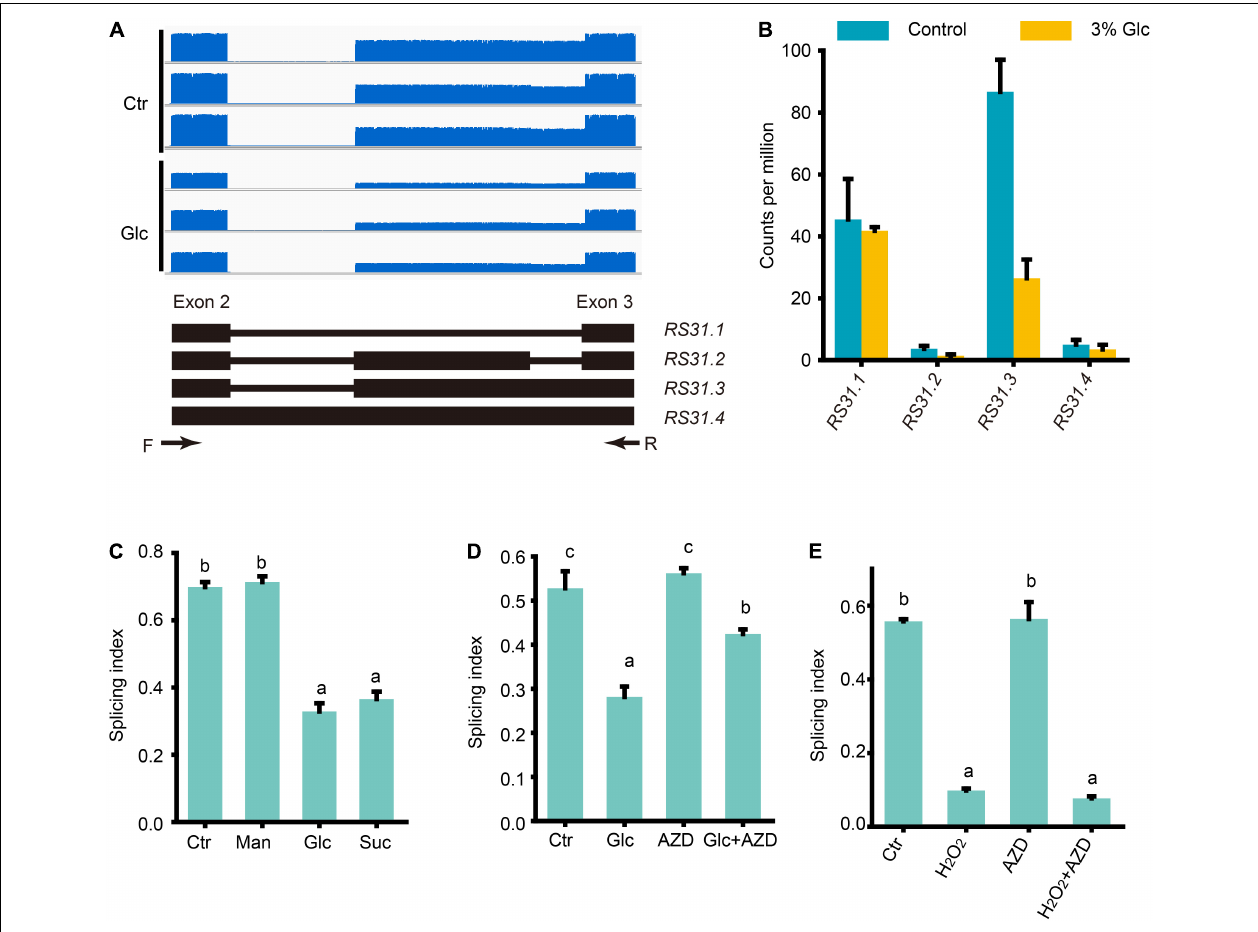
FIGURE 6 | Glucose stress regulates AS pattern change of RS31 via TOR pathway. (A) Gene model, AS isoforms and IGV coverage diagrams of RS31 . Black arrows represent the binding sites of the primers of RT-PCR in (C–E) . (B) Transcription level of RS31 transcript variants by Nanopore sequencing. (C) The splicing index (SI) of RS31 transcripts upon different sugar treatments. (D) The SI of RS31 transcripts upon glucose and AZD treatments. (E) The SI of RS31 transcripts upon H 2 O 2 and AZD treatments. Ctr, 0% glucose; Glc, 3% glucose; Man, 3% mannitol; Suc, 3% sucrose; AZD, 0% glucose + 20 µ M AZD-8055; Glc + AZD, 3% glucose + 20 µ M AZD-8055; H 2 O 2 , 50 µ M H 2 O 2 ; AZD, 0% glucose + 20 µ M AZD-8055; H 2 O 2 + AZD, 50 µ M H 2 O 2 + 20 µ M